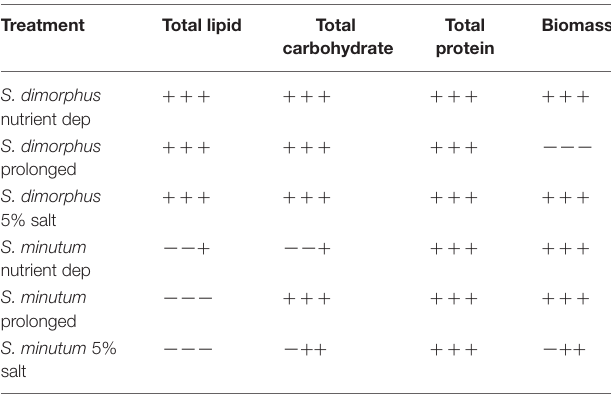
TABLE 1 | Statistical analysis of the treatments compared to the samples at start of the treatments